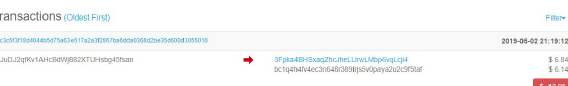
Figure 4. Blockchain.info verifying the transaction.